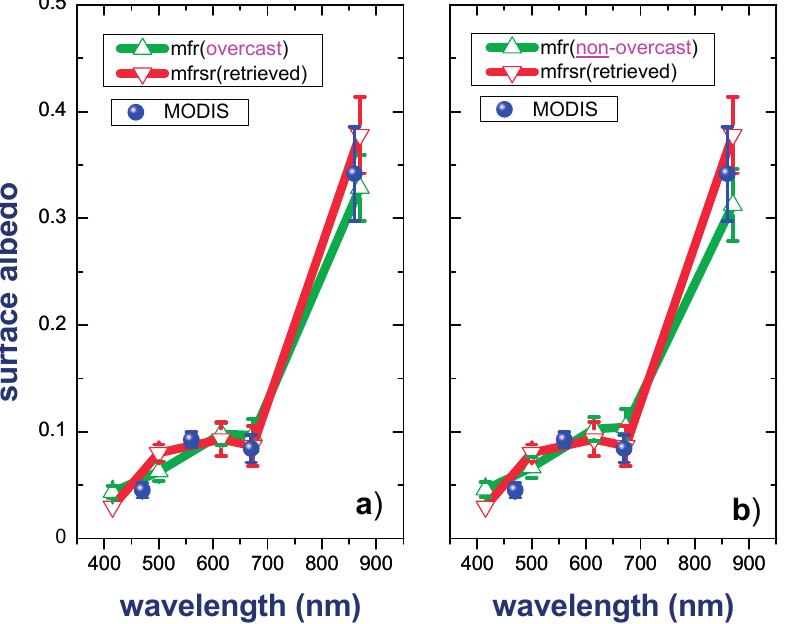
Figure 4. Mean values (±standard deviations) of the tower-measured local (green), MFRSR-retrieved areal-averaged (red) and MODIS-derived (blue) white-sky surface albedos as a function of wavelength. The mean local values represent overcast ( a ) and non-overcast ( b ) conditions that occurred during the two-month period of interest (Figure 3). The MODIS-derived albedos are plotted at the MODIS nominal wavelengths of 470, 560, 670, and 860 nm. For both figures, the MODIS-derived and MFRSR-retrieved albedos are the